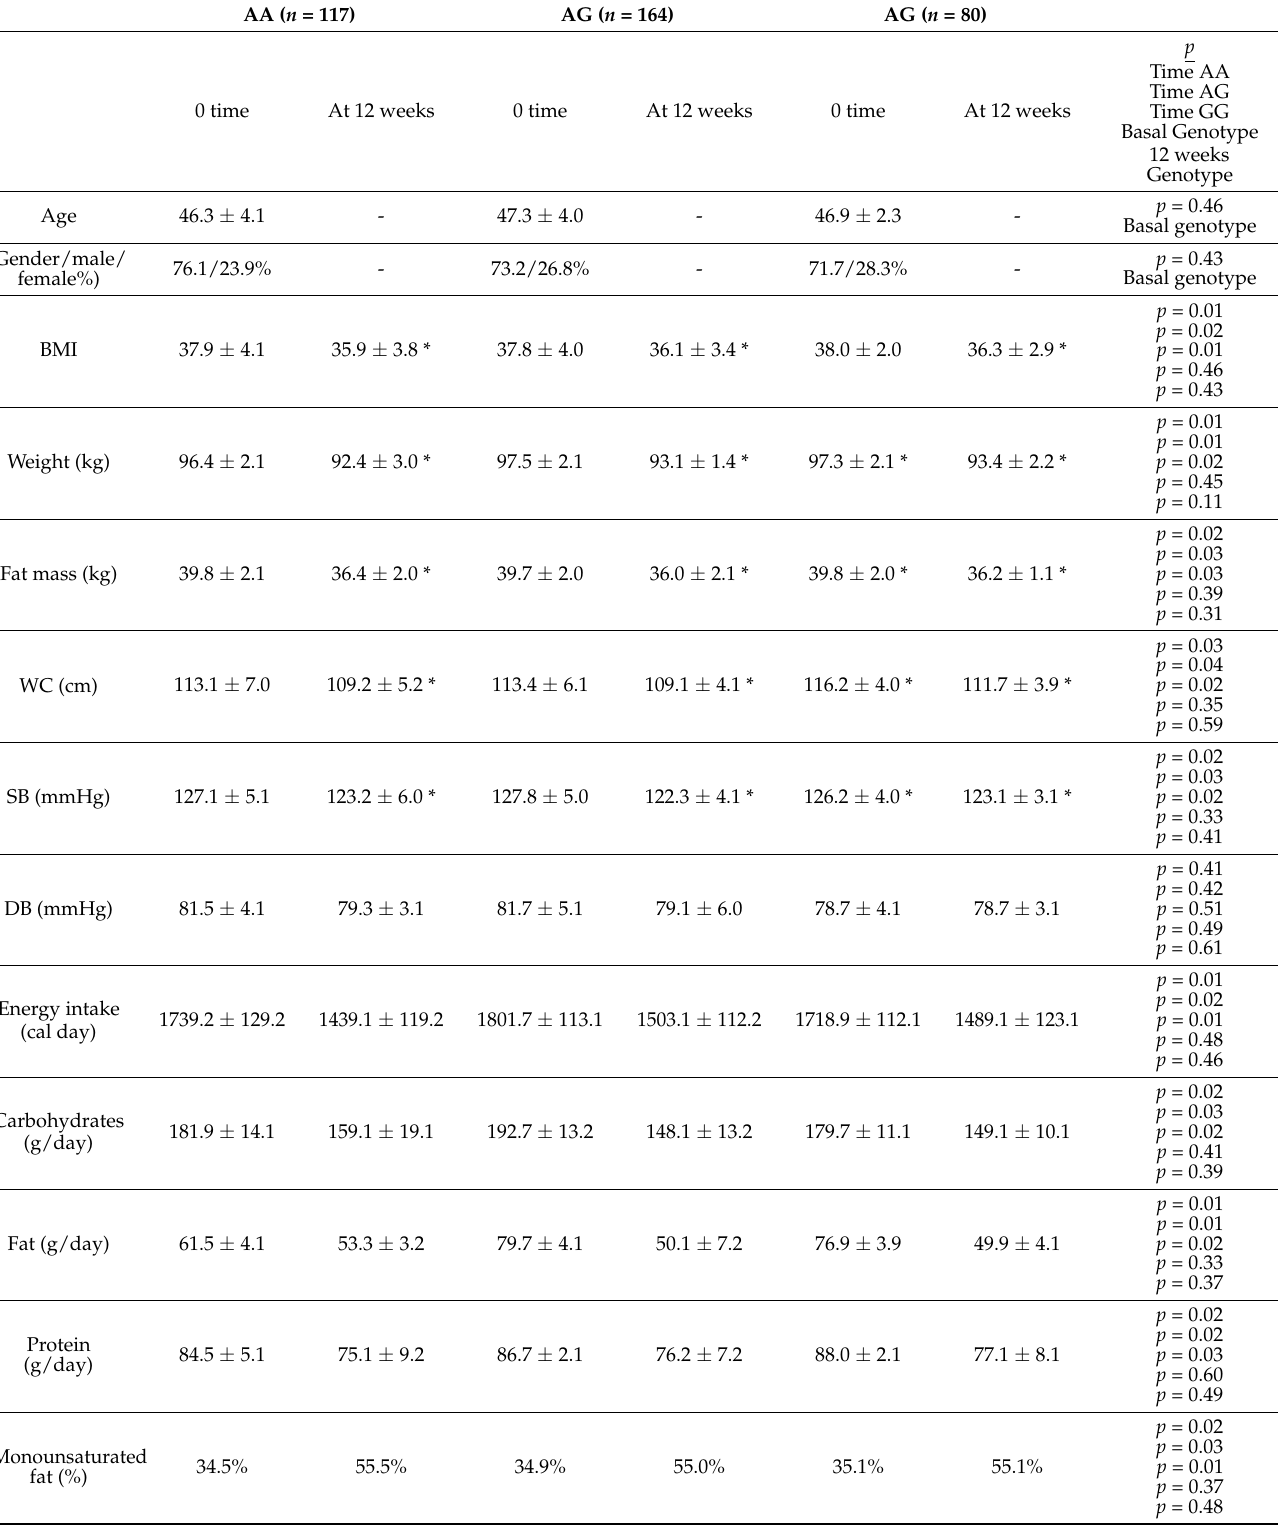
Table 1. Changes in anthropometric parameters, dietary intakes, and physical activity rs3774261 (mean ±